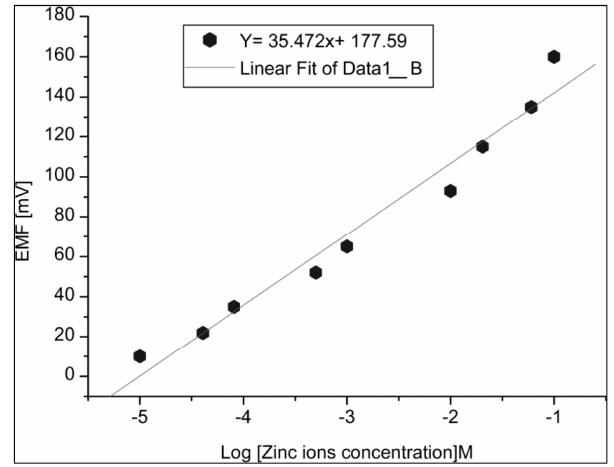
Figure 7. Calibration curve for zinc ion detection using ionophore-coated ZnO nanorods [48].